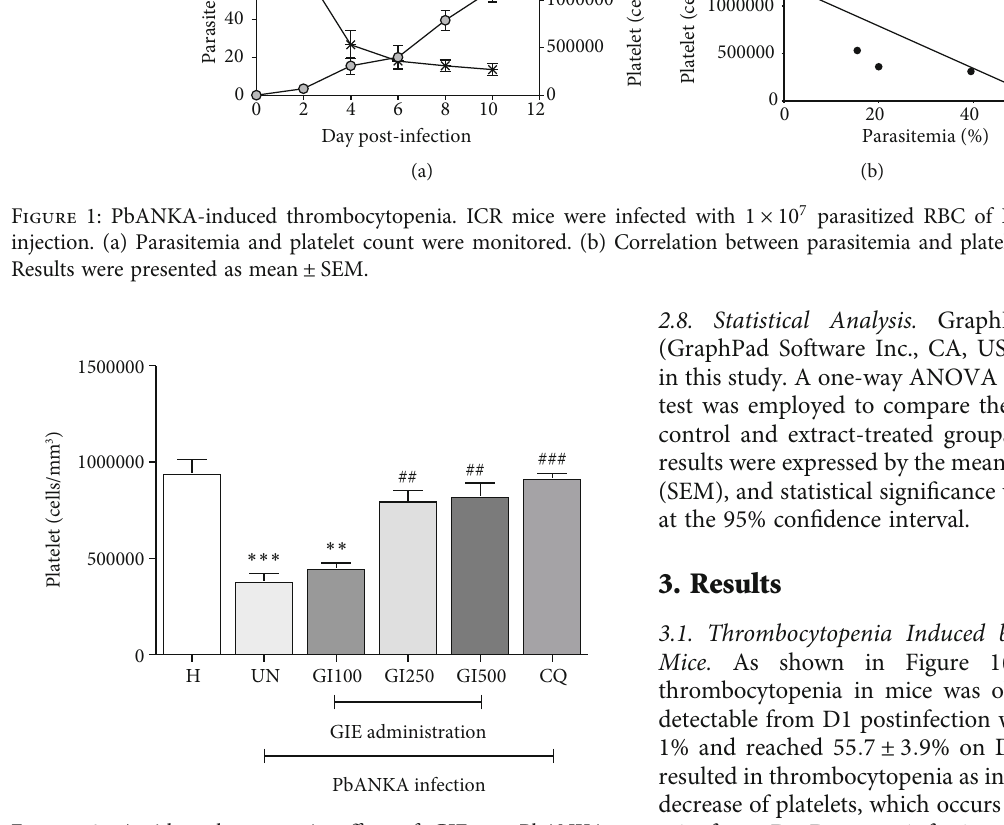
Figure 2: Antithrombocytopenia e ff ect of GIE on PbANKA- infected mice. Groups of ICR mice were inoculated with 1 × 10 7 parasitized RBC by intraperitoneal injection. GIE (100, 250, and 500mg/kg) was given orally by gavage for 4 consecutive days. Platelet count was measured using an automated analyzer. The results were presented as mean ± SEM . H: healthy; UN: untreated; GI100, GI250, and GI500: GIE treatment at doses of 100, 250, and 500 mg/kg; CQ: 10mg/kg of chloroquine. ∗∗ p < 0 : 01 and ∗∗∗ p < 0 : 001 compared to H. ## p < 0 : 01 and ### p < 0 : 001 compared to